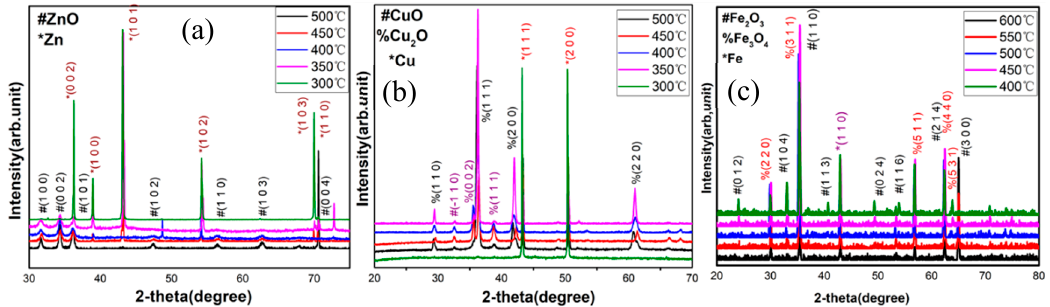
Figure 2. XRD patterns of the metal oxide nanostructures grown at various temperatures: ( a ) ZnO nanostructures were grown at 300–500 °C; ( b ) CuO nanostructures grown at 300–500 °C; ( c ) Fe 2 O 3 nanostructures grown at 400–600 °C.